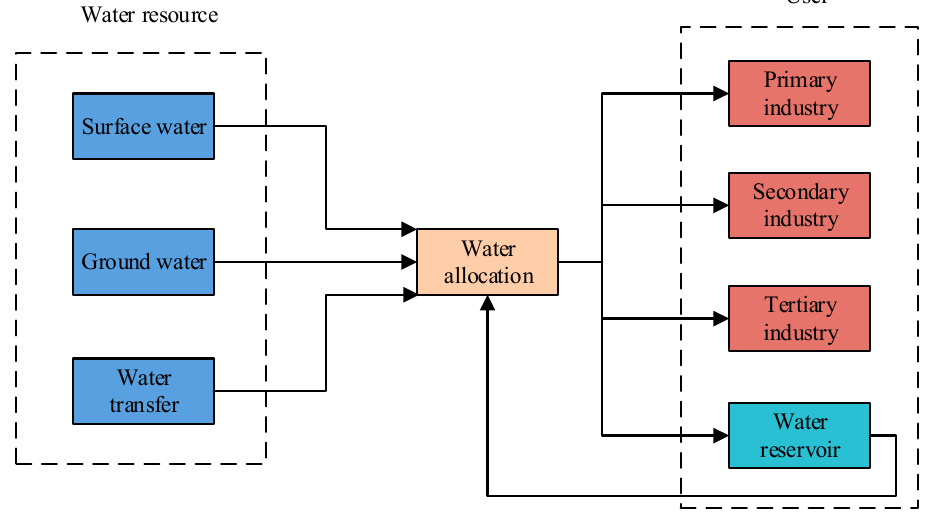
Figure 1. The multiple water sources for urban water supply system structure. Table 1. Model parameters.